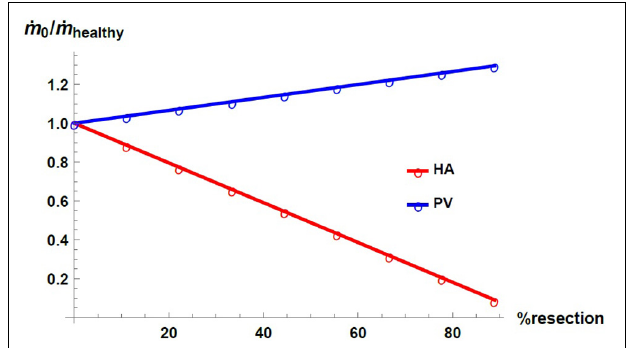
FIGURE 8 | Inlet mass flow rate as a function of resection percentage at the HA network (red) and the PV network (blue). The mass flow rate is normalized by its corresponding value in the healthy